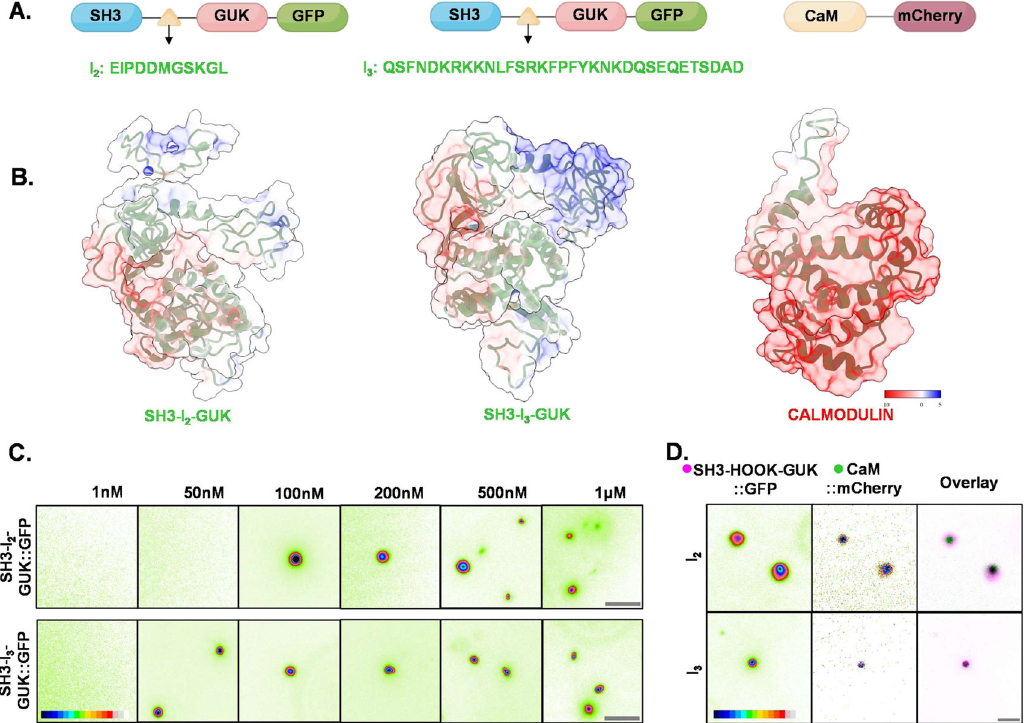
Fig. 6 In vitro liquid – liquid phase separation of SAP97/hDLG. A A scheme indicating puri fi ed SH3-HOOK-GUK isoforms, namely I 2 and I 3 , of C-terminal fragments of SAP97/hDLG and Calmodulin fl anked by enhanced green fl uorescent protein and monomeric mCherry, respectively, at the C-terminus. B The electrostatic distribution of net surface charges of SH3- I 2 -GUK, SH3- I 3 -GUK and Calmodulin. Pseudo color scalebar indicates transition from positive to negative (red to blue). C Top and bottom panels indicate the phase separation of C-terminal isoforms, namely SH3- I 2 -GUK::GFP and SH3- I 3 -GUK::GFP in response to their increasing concentration at 20% PEG. SH3- I 2 -GUK::GFP nucleation occurs at a concentration higher than SH3- I 3 -GUK::GFP, indicating that spontaneous phase transition of I 3 isoform of SAP97/hDLG occurs at a lower concentration than that of the I 2 isoform. Scalebar indicates 5 µ m. D Incubation of 2 µ M of CaM::mCherry with 1 µ M SH3- I 2 -GUK::GFP or SH3- I 3 -GUK::GFP in presence of 2 mM CaCl 2 resulted in the formation of co- condensates of SAP97/hDLG and Calmodulin. In the overlap images, SAP97/hDLG is in magenta and Calmodulin in green and their overlay is indicated by black. Scalebar indicates 3 µ